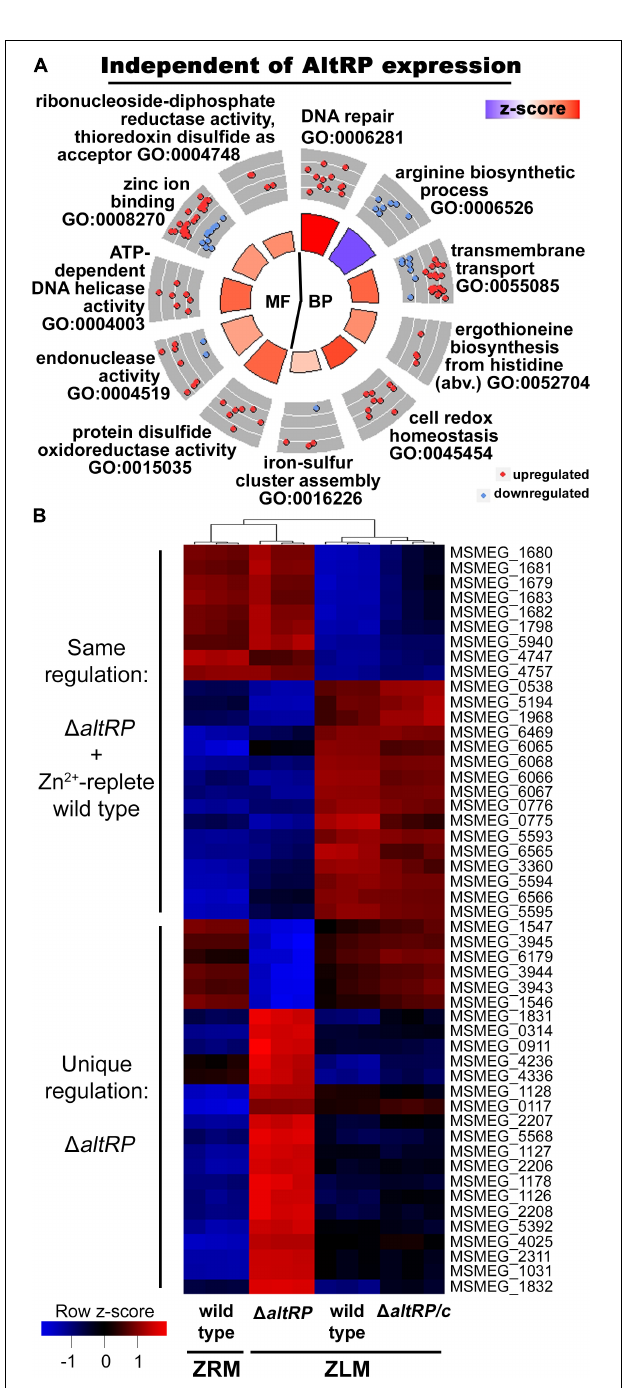
FIGURE 4 | Differentially expressed genes independent (A) and dependent (B) of AltRP expression during Zn 2 + -limitation. (A) Circle plot showing enriched GO terms in the DE genes shared between the wild type and the (cid:49) altRP mutant during Zn 2 + limitation (i.e., both grown in ZLM and compared to the wild type grown in ZRM). DE analysis was conducted on three independent biological replicates for each strain. See Figure 1C for circle plot explanation. (B) Heatmap showing relative transcript expression levels in all strains and conditions for the top 50 DE genes (by adj.P.val) between the (cid:49) altRP vs. wild type in ZLM comparison. For each strain or condition, the relative expression for each independent biological replicate is shown in the